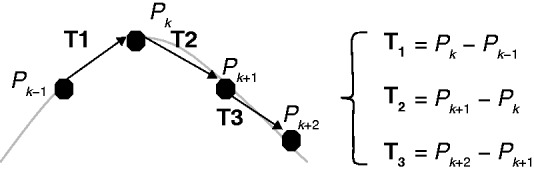
Graphical representation of points, P, and vectors, T, to calculate the SOAM index. Vectors, T, are constructed from points, P, which describe the root structure. Adapted from Bullitt et al. (2003).